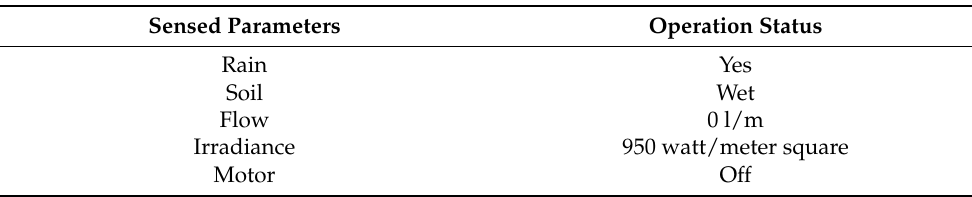
Table 5. Physical parameters of smart-sensor-based solar-powered system under raining condition and motor status off.